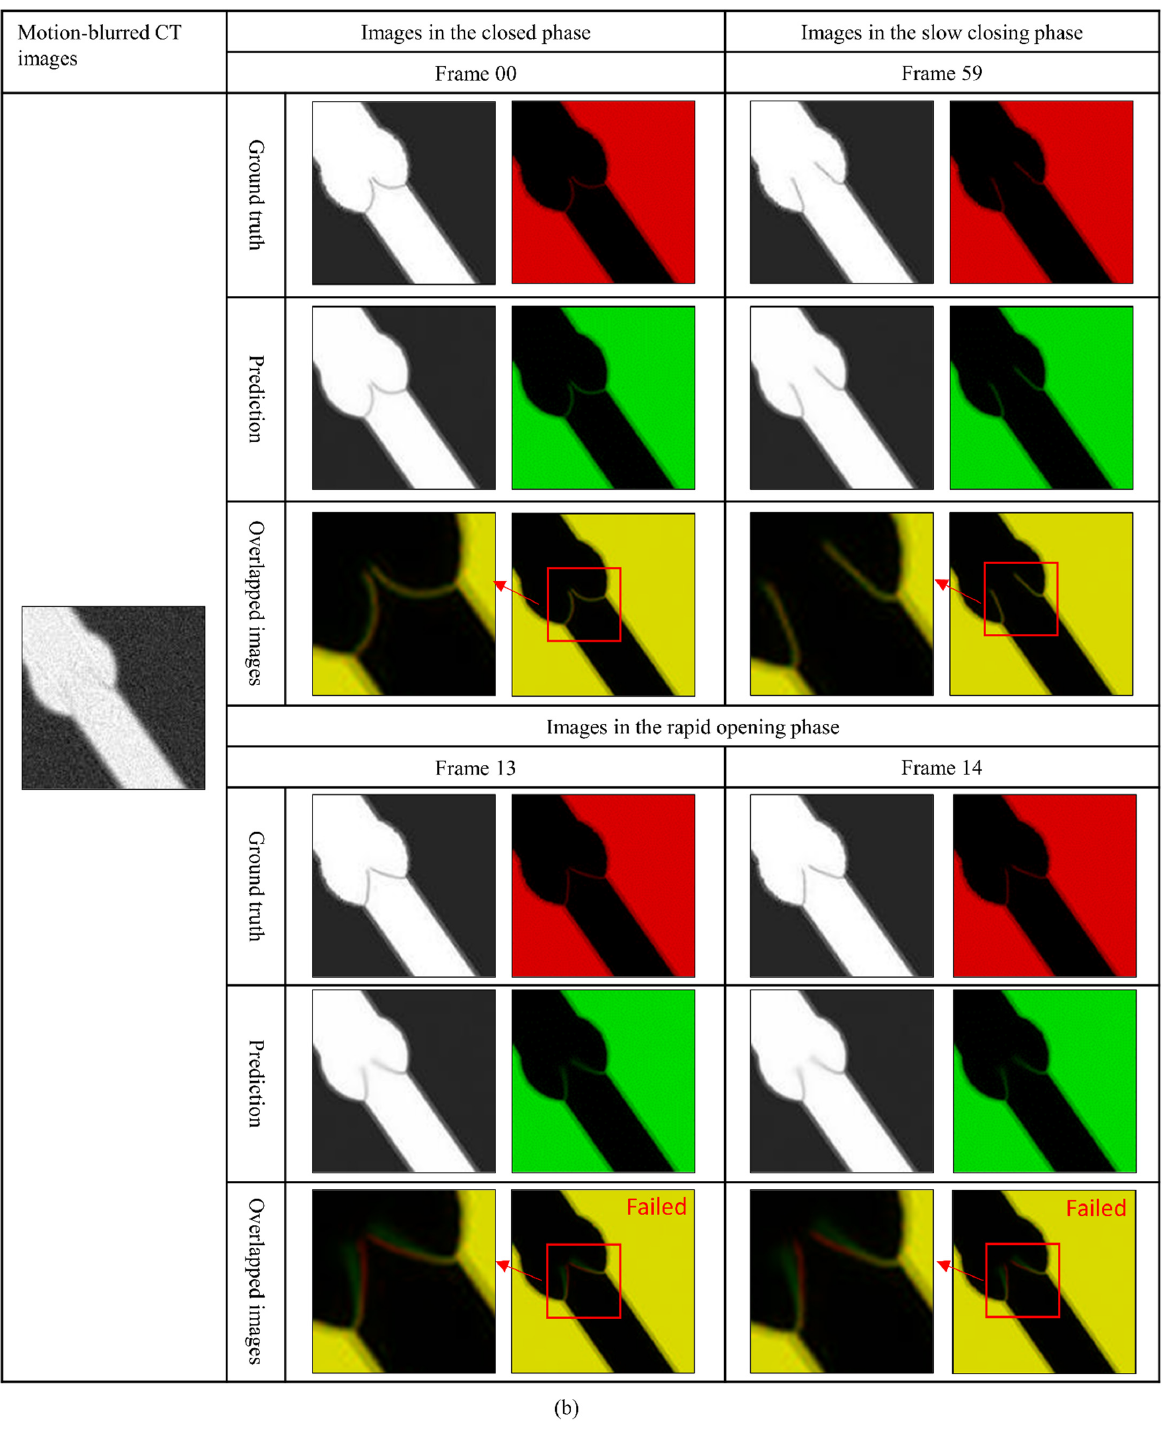
Figure 5. Two examples of prediction results of our trained model. The image on the left is a motion-blurred CT image. We selected representative images from each motion phase. Images in the first row are ground truth and color-converted images. Images in the second row are predicted images and color-converted images. Images in the third row are partially enlarged images and overlapped images. In the overlapped images, correctly predicted pixels will turn yellow or remain black, whereas mispredicted pixels will remain red or green. ( a ) An example of good performance of our trained model. ( b ) An example of bad performance of our trained model. Our trained model failed in the images of rapid opening